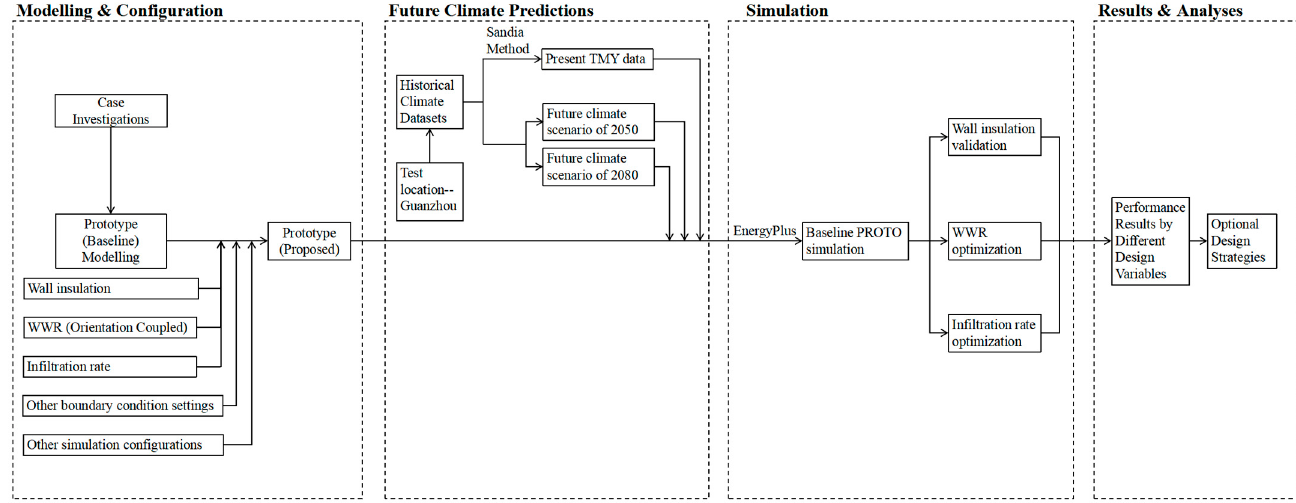
Figure 2. Flowchart of the methods used in this